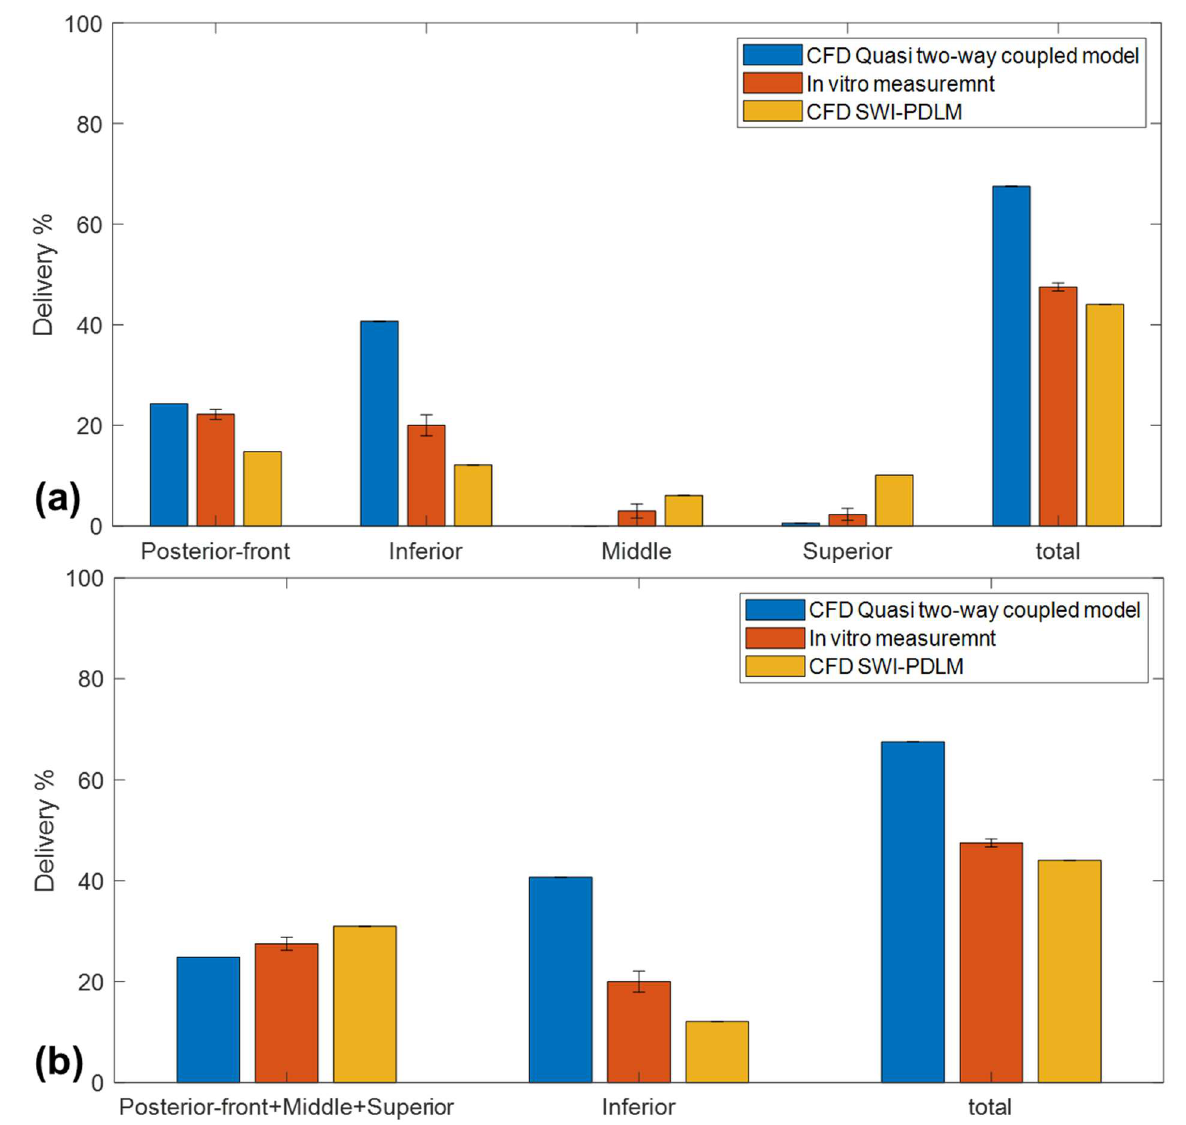
Figure 8. Comparison of the Flonase spray deposition in ( a ) specific posterior regions ( b ) in the upper and lower posterior regions predicted by the SWI-PDLM model and the quasi two-way coupled Lagrangian model with the in vitro measurements.